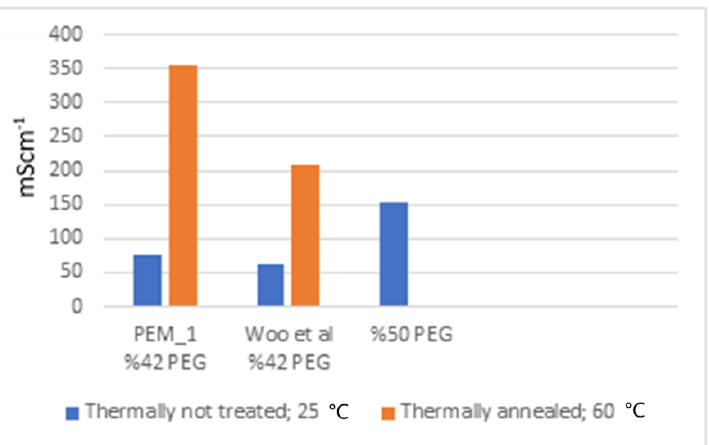
Figure 12. Comparison of conductivity of the EAN-doped PEG-PI membranes containing 6FDA- PDODA-PEG1500.